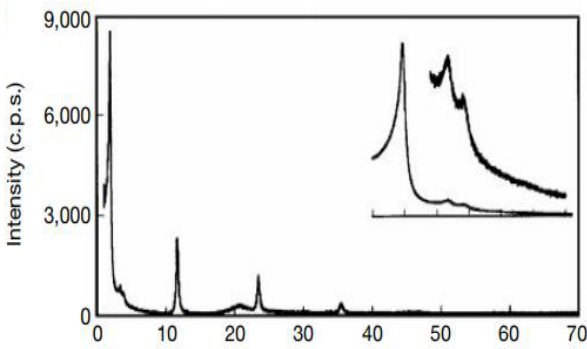
Figure 3. X-ray diffraction (XRD) patterns of PMO with crystal-like walls. Reprinted with permission from Springer Nature Customer Service Centre GmbH: Springer Nature [118]; copyright (2002).